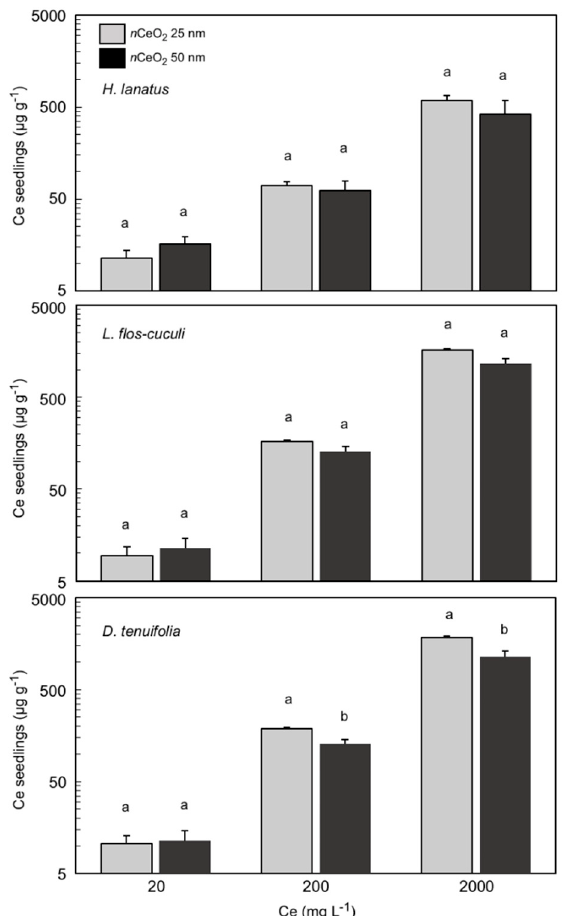
Figure 5. Ce concentration in seedlings of H. lanatus , L. flos-cuculi and D. tenuifolia , grown in Petri dishes and treated with solutions of n CeO 2 25 nm and n CeO 2 50 nm at 20, 200 and 2000 mg L − 1 , respectively. The values are mean ± SD (standard deviation) of 3 replicates. Statistical significance of the treatments (ANOVA p value) for each Ce concentration is reported. Different letters indicate statistical differences ( p ≤ 0.05).